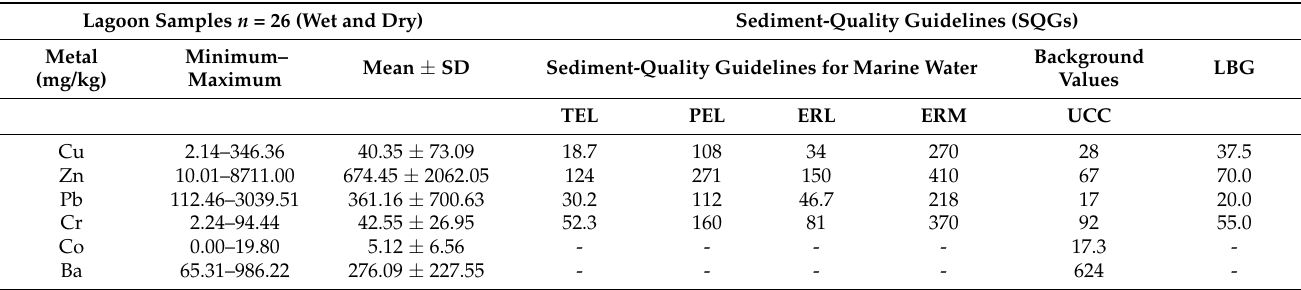
Figure 8. Wet and dry biological-risk index (m-ERM-Q). Table 5. Comparison of the trace element concentrations with background values and